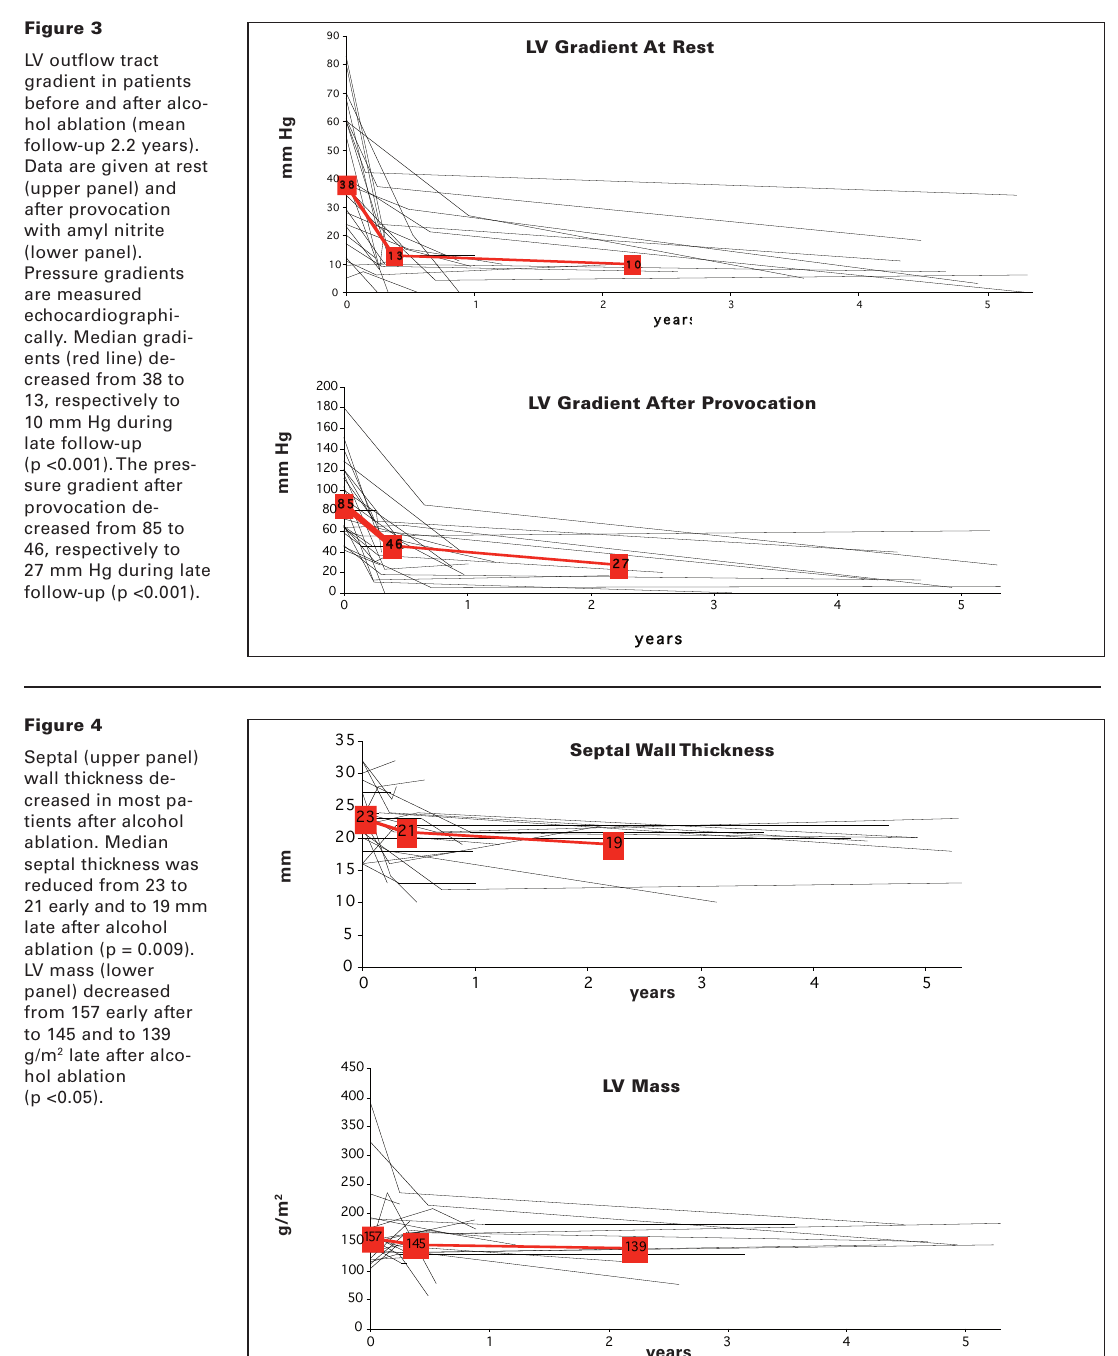
Figure 3 lV outflow tract gradient in patients before and after alco- hol ablation (mean follow-up 2.2 years). data are given at rest (upper panel) and after provocation with amyl nitrite (lower panel). Pressure gradients are measured echocardiographi- cally. Median gradi- ents (red line) de- creased from 38 to 13, respectively to 10 mm Hg during late follow-up (p <0.001).The pres- sure gradient after provocation de- creased from 85 to 46, respectively to 27 mm Hg during late follow-up (p <0.001).